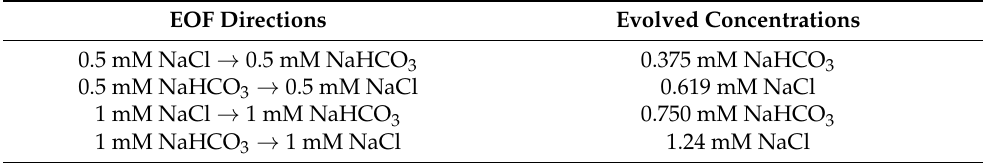
Table 6. Evolved concentrations for different EOF directions obtained via simulations. Arrow indicates EOF direction.